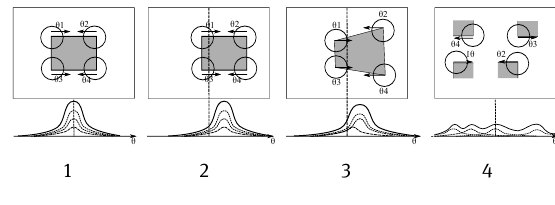
Figure 20: Schematic example of pose estimation applied to a square. (1) is the learned object at the image center. Below is the activity in the PI group. It creates a peak at the object location. (2) shows the same square translated and the translation result in the PI group. (3) is the same square with deformation, and its estimated pose below. (4) contains same local view as in (1) scattered in the image.